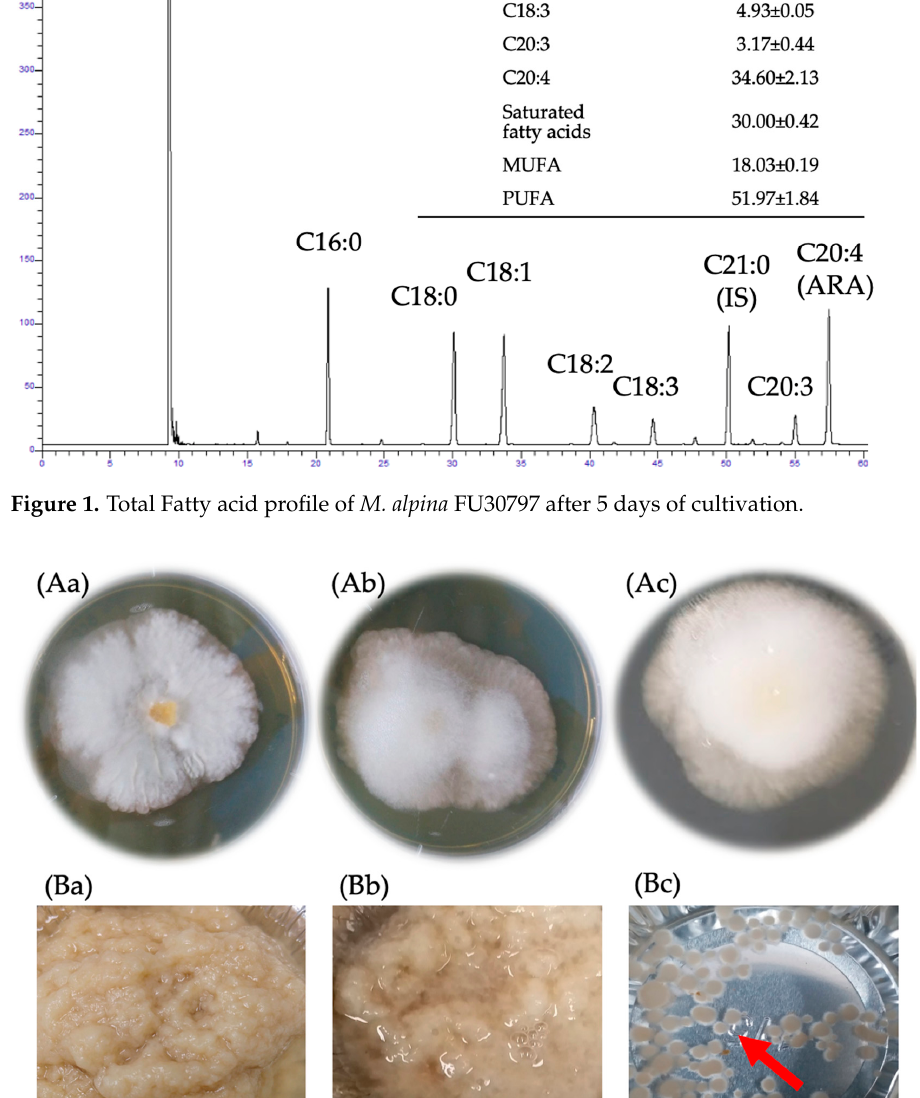
Figure 2. Morphology of Mortierella alpina (a. 32738, b. FU30281, c. FU30797): ( A ) in plate and ( B ) biomass from suspension